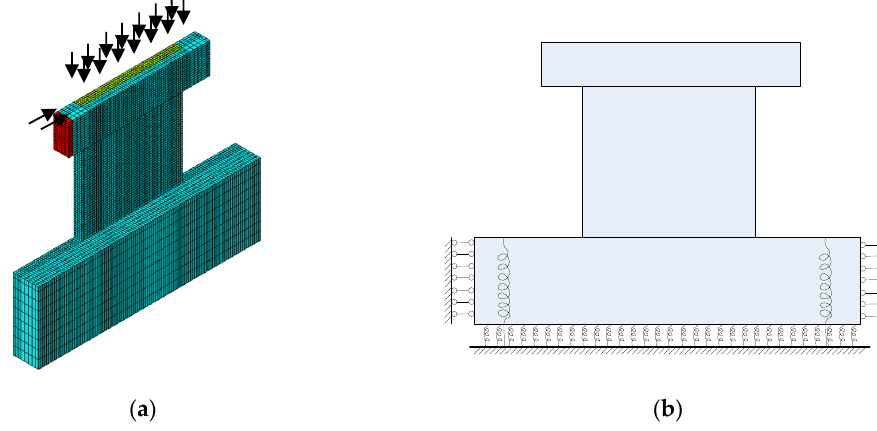
Figure 2. FE model in ABAQUS. ( a ) FE models; ( b ) Boundary conditions of FE models.